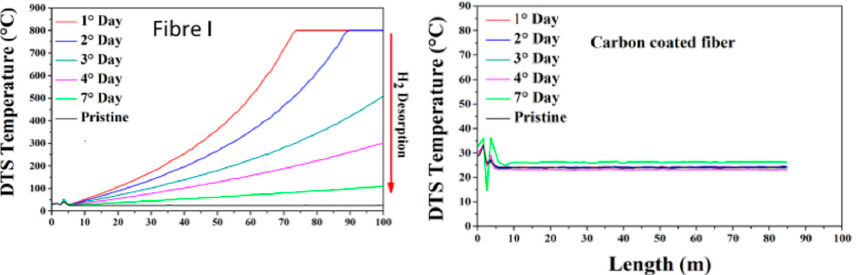
Figure 16. Influence of hydrogen exposure on temperature sensing based on Raman scattering for standard ( left ) and carbon ( right ) primary coating. Adapted with permission from [52]. Copyright IEEE 2015.